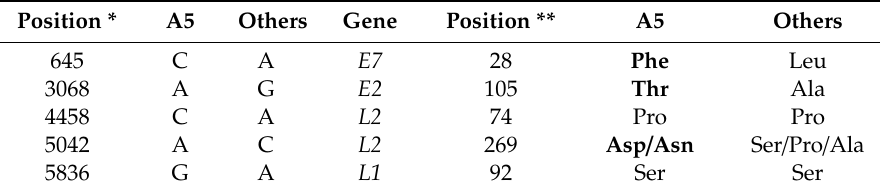
Table 4. SNPs characteristic for A5